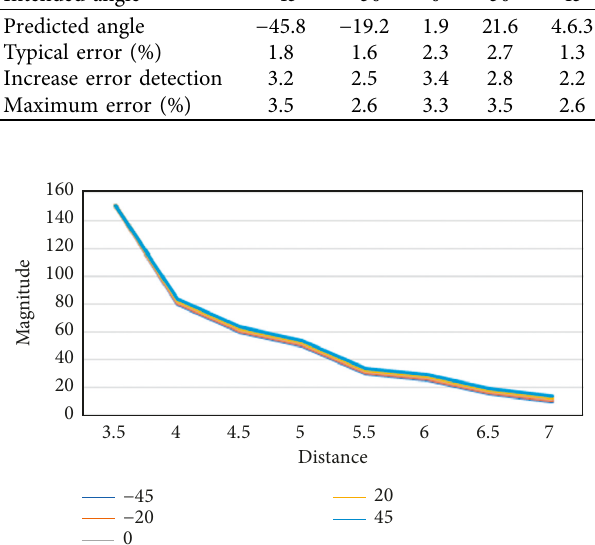
Figure 8: Comparison between the magnitude and distance of the robot to the ferromagnetic